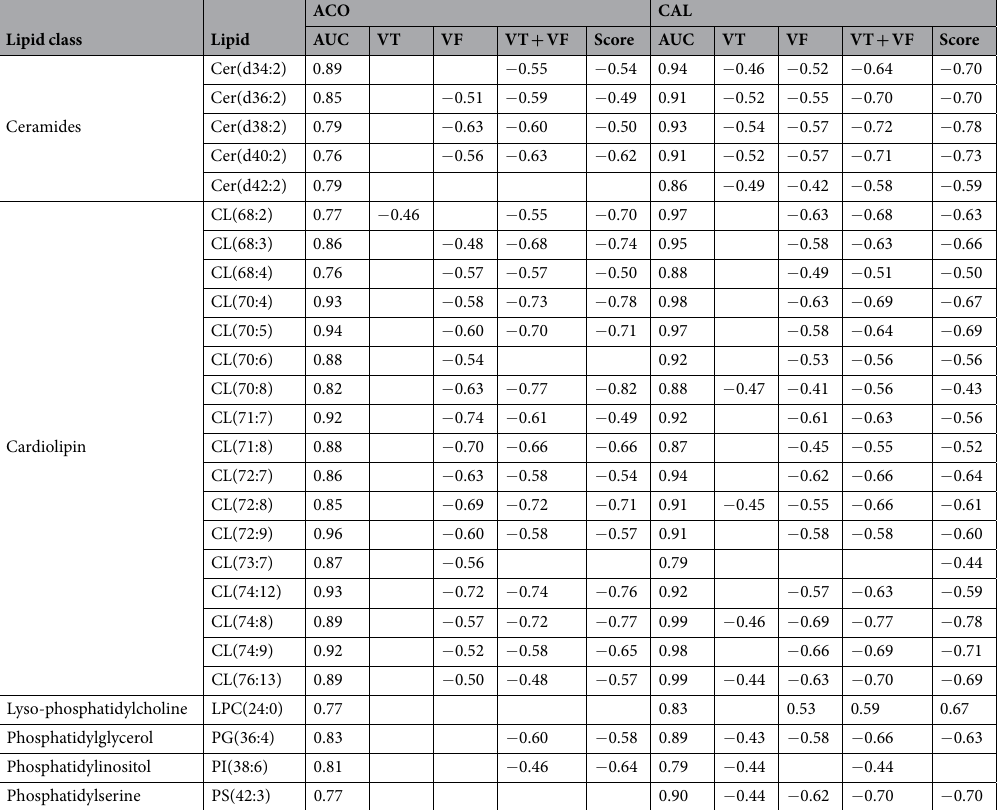
Table 2. Correlations between differential lipids and electrophysiological parameters. Notes: AUC: area under curve. VT: ventricular tachycardia duration. VF: ventricular fibrillation duration. VT + VF: the total duration of ventricular tachycardia and ventricular fibrillation. Score: the arrhythmia scores were calculated based on the Lambeth Conventions principles; in all columns except AUC, the data in the table were the correlation coefficients between the relative amounts of lipids with these parameters.